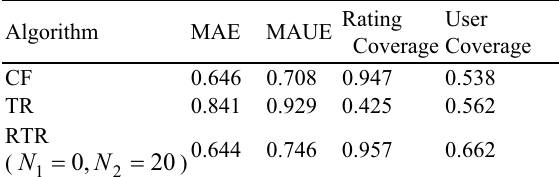
Table 7. The results of running CF,TR and RTR on Flixster.